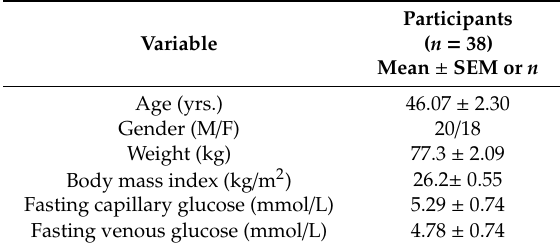
Table 3. Subjects Characteristics.